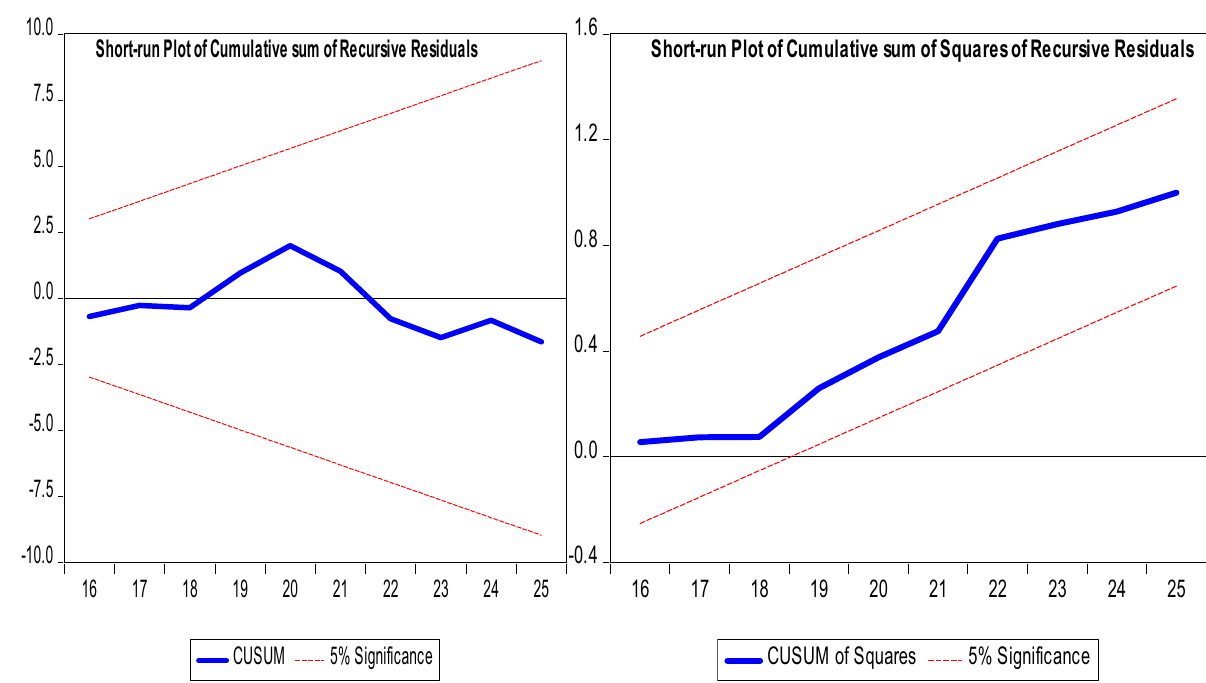
Fig. 2 Plot of Cumulative sum of squares of Recursive Residuals (CUSUMQ) for ARDL